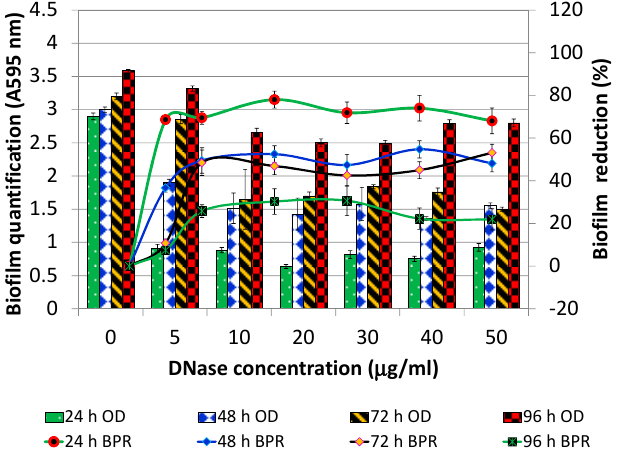
Figure 1. Effect of DNase I (without Mg 2+ ) pretreatment on P. aeruginosa PAO1 biofilm grown for 24, 48, 72, 96 h in varying concentrations of DNase I (0–50 µg/mL). Biofilm quantification (A595 nm) on the primary y -axis and biofilm percentage reduction (line graph) on the secondary y -axis. OD: optical density; BPR: biofilm percentage reduction.